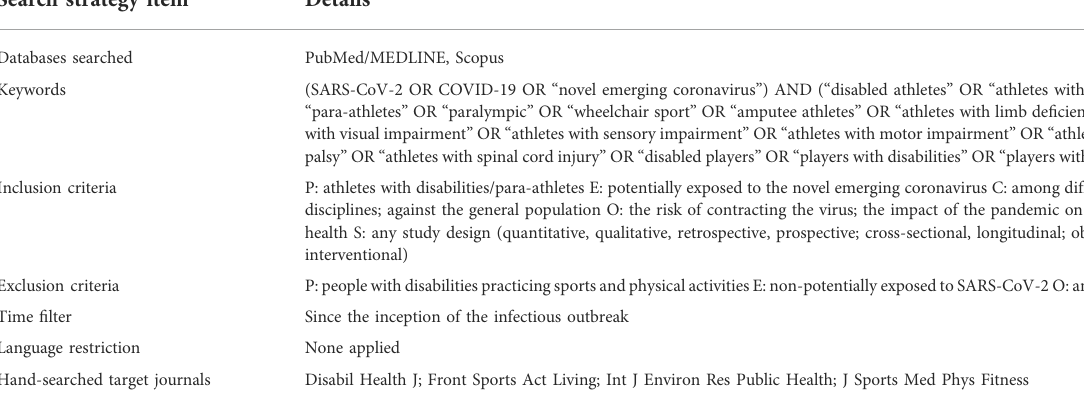
TABLE 1 Search strategy adopted in the present